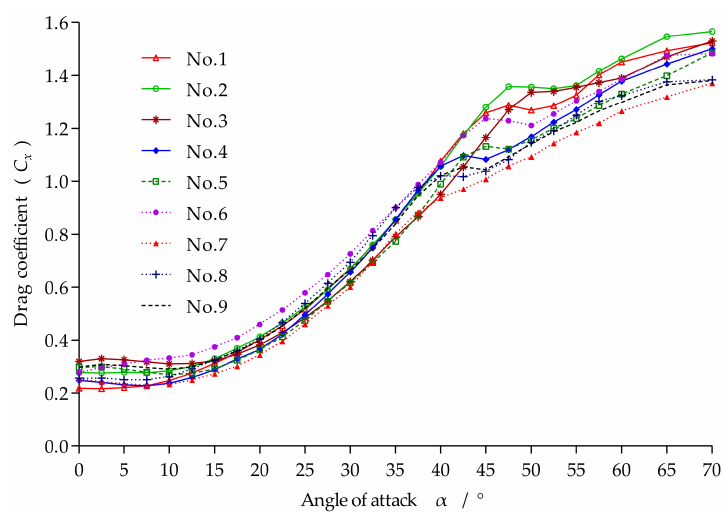
Figure 7. C x versus the angle of attack α for the nine otter board